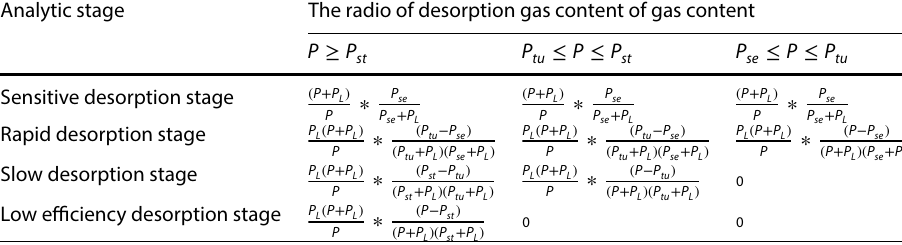
Note: P is shale reservoir pressure, P se is sensitive pressure, P tu is transition pressure, P st is starting pres-